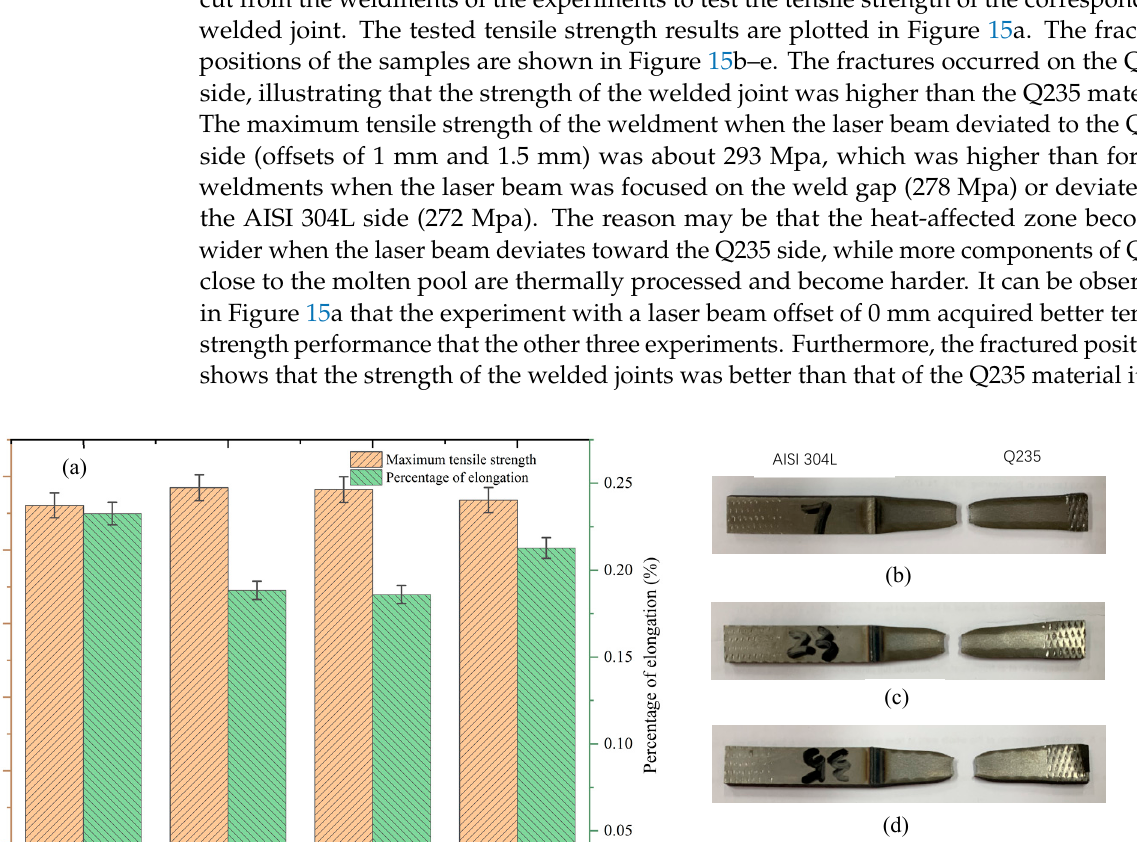
Figure 14. The cross-section views and hardness test results with different laser beam offsets: ( a ) laser beam offset = 0 mm; ( b ) laser beam offset = 1 mm; ( c ) laser beam offset = 1.5 mm; ( d ) laser beam offset = − 1 mm; ( e ) hardness test results. Table 7. The average hardness values of the welded joints with different laser beam offsets.